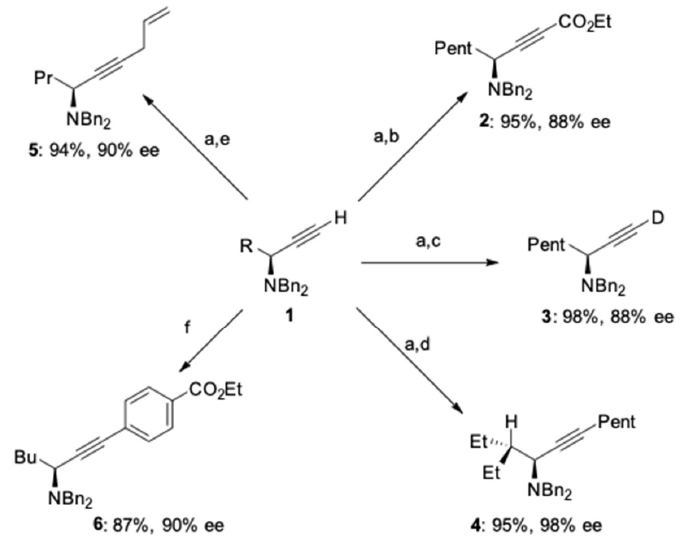
Figure 15. Functionalization of the terminal Figure 15 . Functionalization of the terminal alkynes.